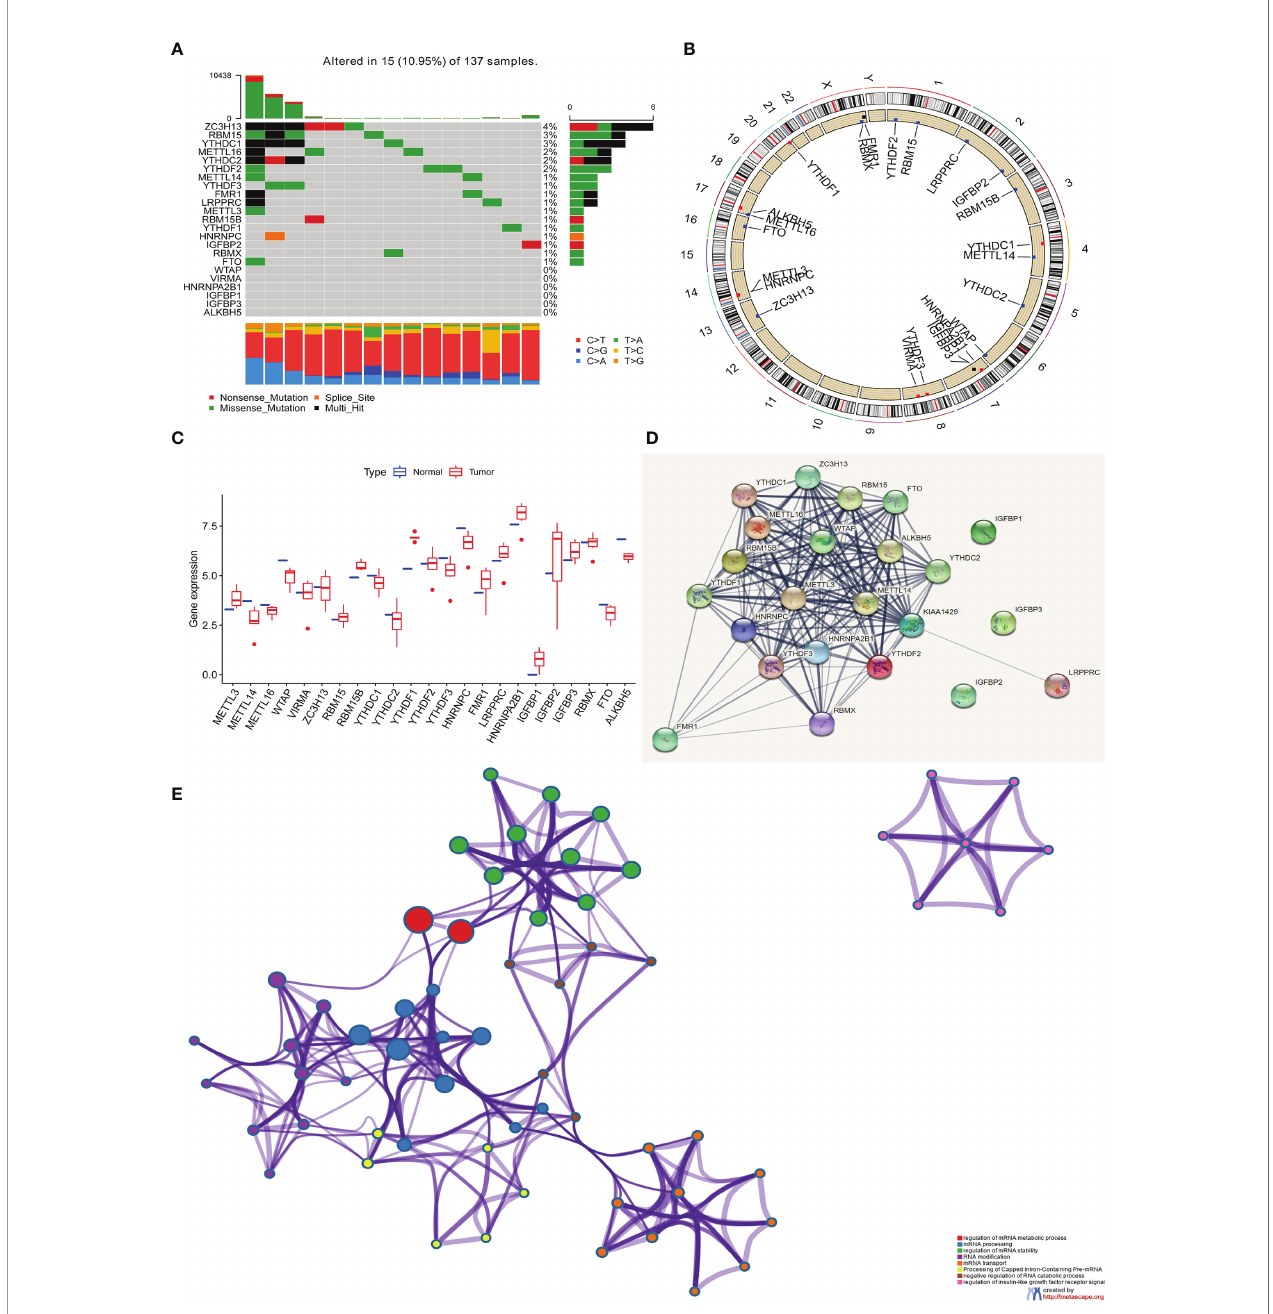
FIGURE 1 | The genetic and expression variant landscape of m 6 A regulators in rectal cancer. (A) The mutation frequency of 23 m 6 A regulatory factors in 137 rectal cancer patients in the TCGA-RC cohort. Each column represents an .individual patient. The bar graph above shows TMB, and the numbers on the right indicate the mutation frequency of each regulatory factor. The bar graph on the right shows the proportion of each variant type and the four different colors indicates four variant types with legends showing in the bottom of the fi gure. The stacked bar graph below shows the proportion of different single nucleotide mutation in each sample, with annotation on the right showing six colors representing six different mutations. (B) Use the GSE87211 cohort to locate the changes of m 6 A regulatory factor CNV on 23 chromosomes. (C) The expression of 23 m6A regulatory factors in normal tissues and rectal tissues. Tumor, red; normal, blue. The upper and lower ends of the box represent a quarter of the value range. The line in the box represents the median value, and the black dots represent the outliers. (D) The protein protein interaction network(PPI) demonstrated the interaction between 23 m 6 A regulatory factors, including 23 nodes and 104edges. (E) The enrichment analysis of 23 m 6 A regulatory factors. These m 6 A regulatory factors have a rich regulatory role in the metabolism of mRNA, primarily involved in the mRNA metabolic process, mRNA processing and mRNA